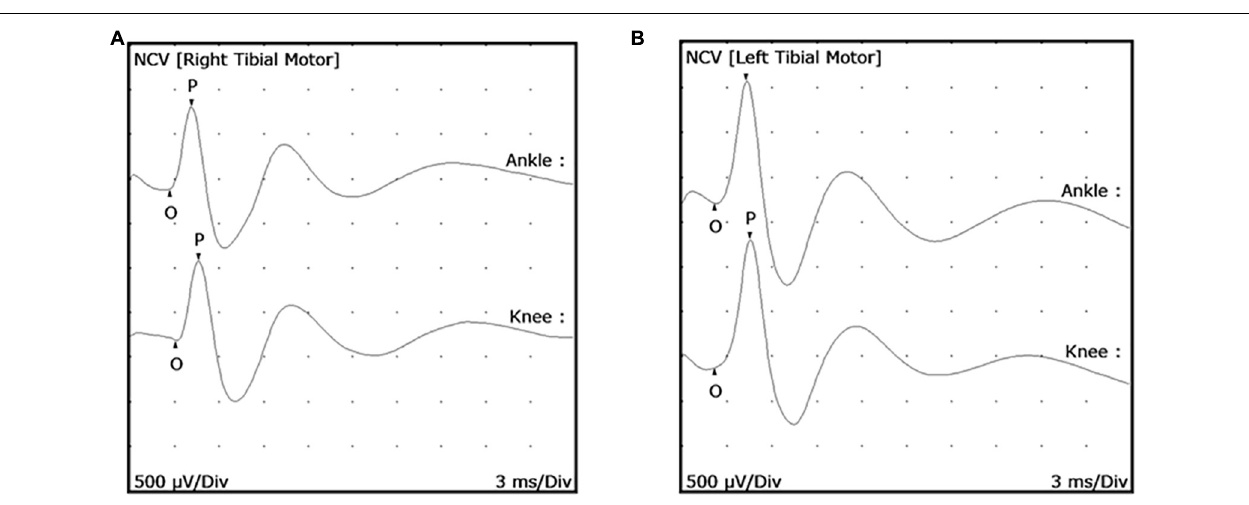
FIGURE 2 | Posterior tibial nerve conduction wave forms in uninfected armadillos. Motor Nerve Conduction Tests (MNCT) were performed on the posterior tibial nerve of uninfected armadillos ( N = 25) using a Cadwell Sierra Summit portable electrophysiology unit. Representative wave forms are shown of a right posterior tibial (A) and left posterior tibial (B) nerve. Measurements were taken from the proximal stimulation site to the active electrode and distal stimulation site to the active electrode to measure the distance between stimulation sites. Compound muscle action potential (cMAP) was measured from onset (O) to the peak (P) in both ankle and knee in response to supra-maximal electrical